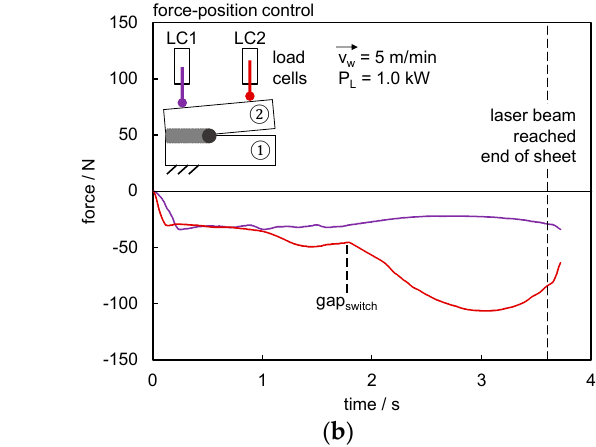
LC2. The different times resulted from the larger effect of the welding process at the be-